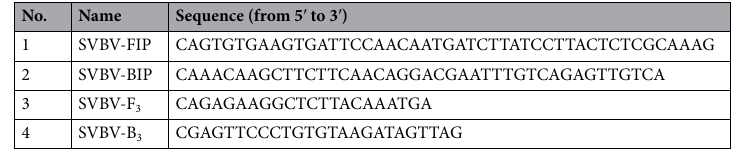
Table 2. Primers designed for LAMP assay of